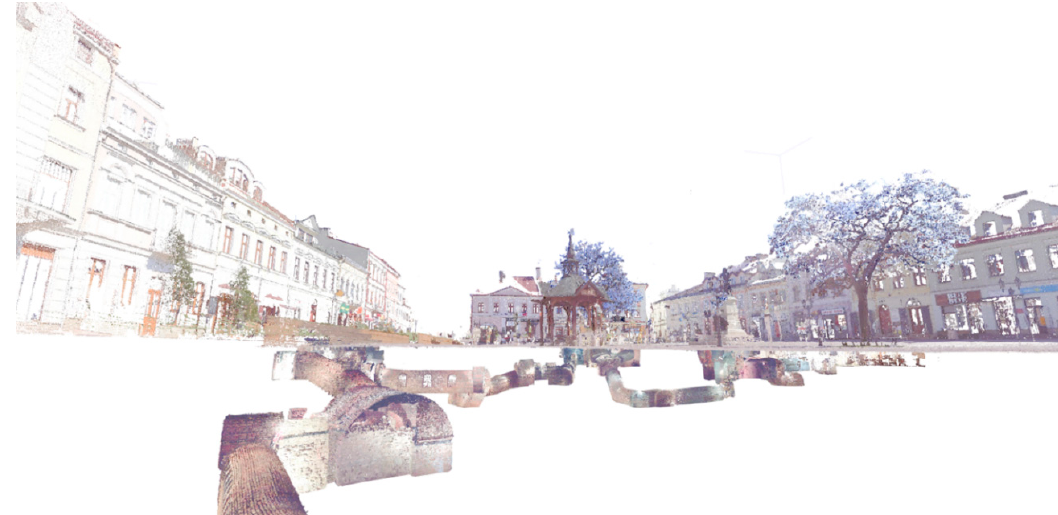
Figure 8. The point cloud of the Underground Tourist Route and Main Market Square coloured by RGB values. Source: own study.